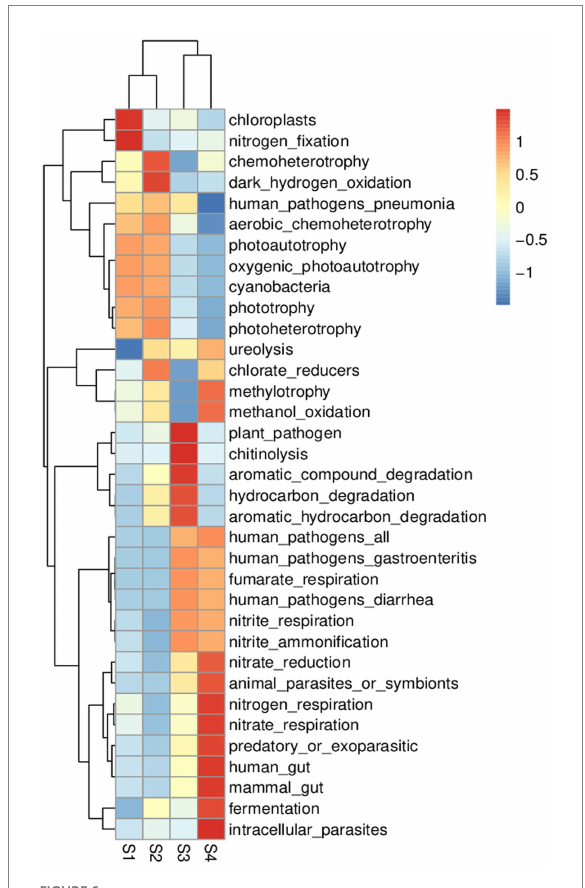
FIGURE 6 FAPROTAX analysis heat map (predicting the function of bacterial